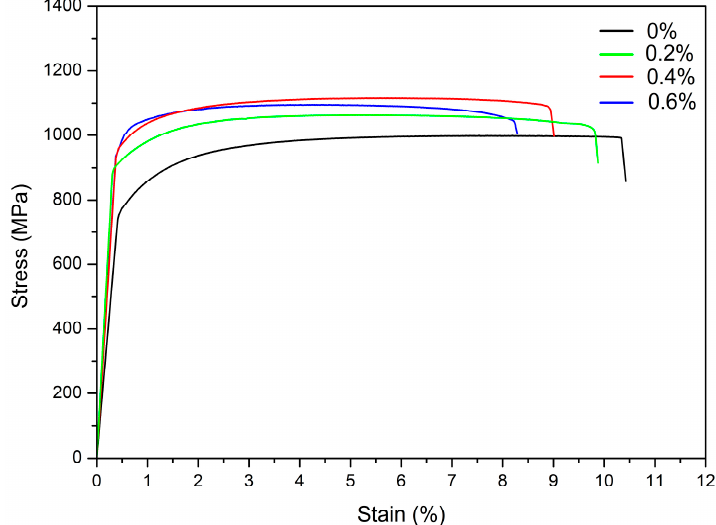
Figure 9. Stress-strain curves from tensile tests of Ti6Al4V alloy refined and reinforced with different weight fractions of ribbon inoculants.